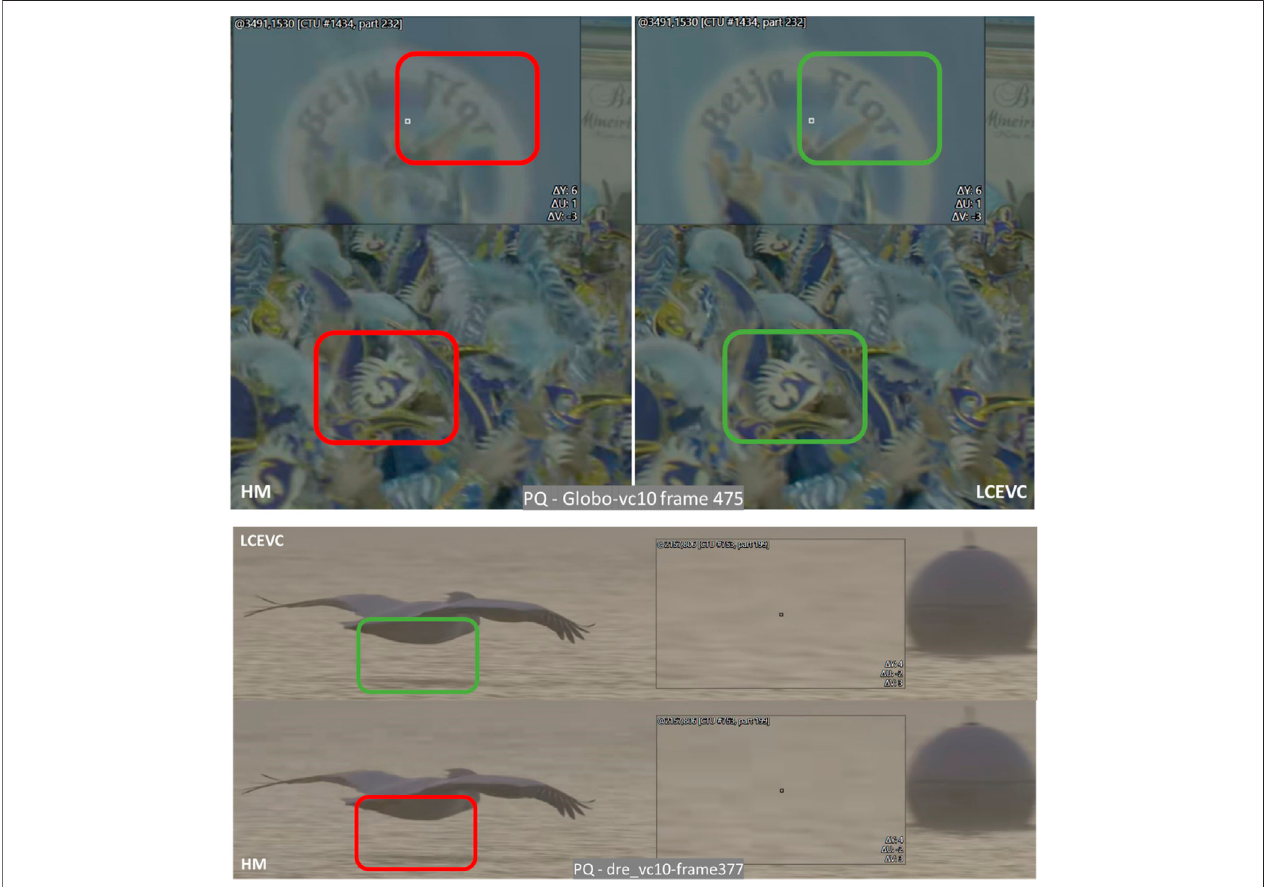
FIGURE 13 | Sequence screenshot from Test 2.1 and 22 (HM on the bottom, LCEVC on the